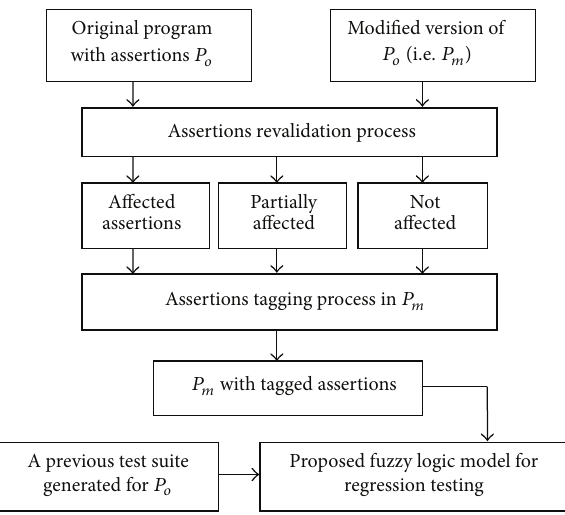
Figure 1: Fuzzy Regression Testing Model for programs with